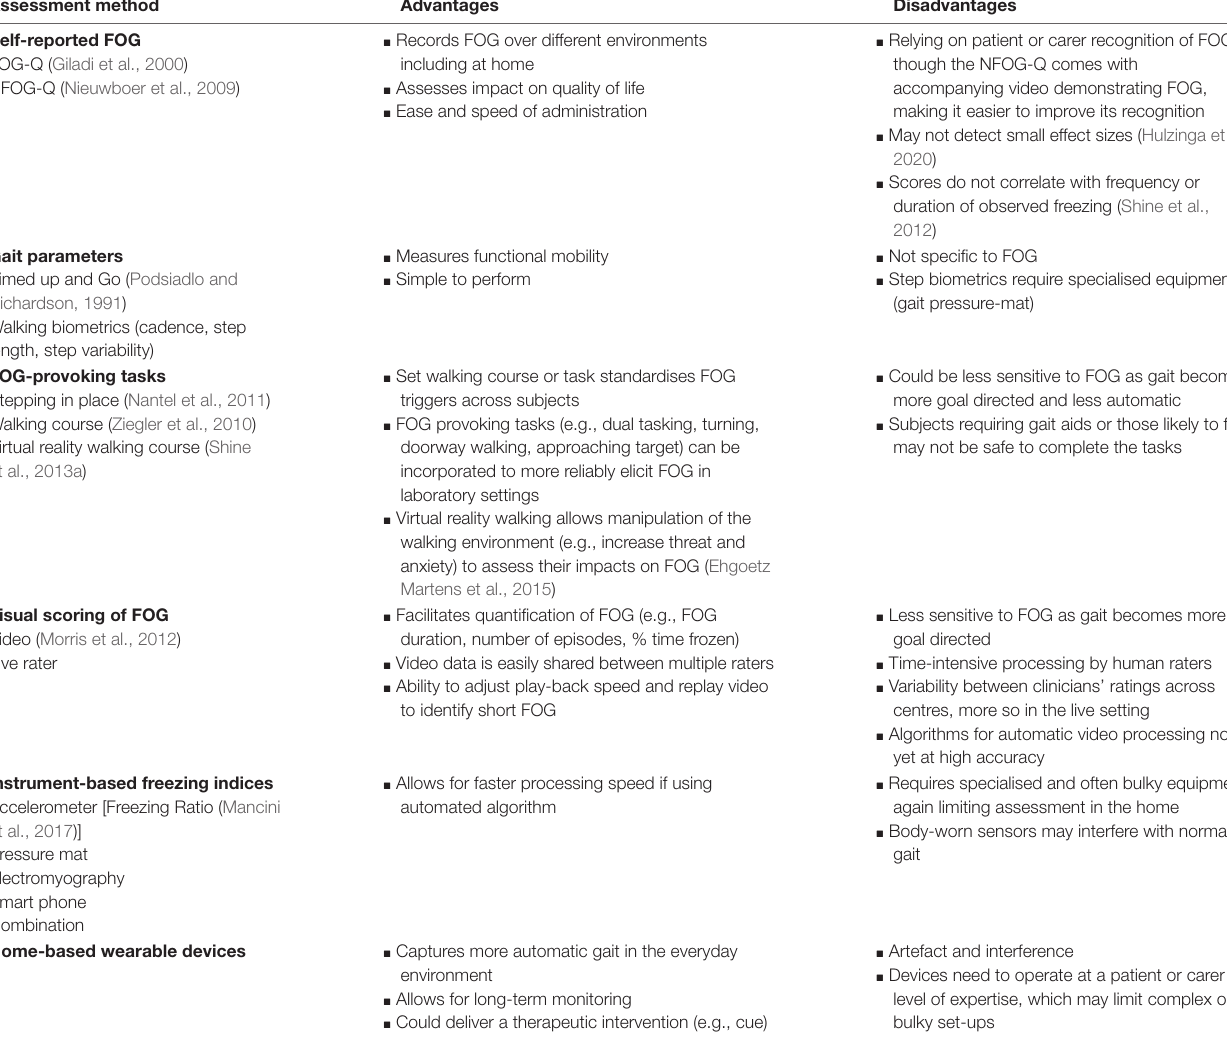
TABLE 1 | Assessment methods in use for FOG measurement, and their advantages and